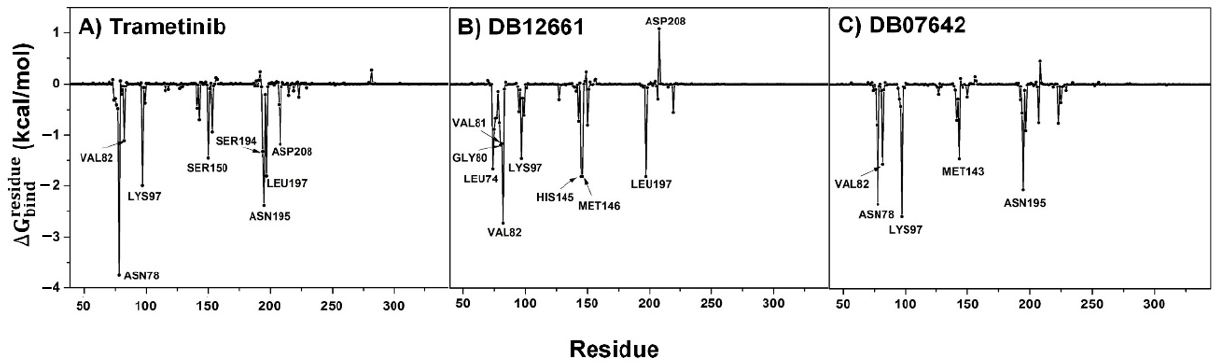
Figure 3. Per-residue decomposition free energy ( ΔG (cid:2928)(cid:2915)(cid:2929)(cid:2919)(cid:2914)(cid:2931)(cid:2915)(cid:2912)(cid:2919)(cid:2924)(cid:2914) ) of the ATPase pocket of MEK1 for the